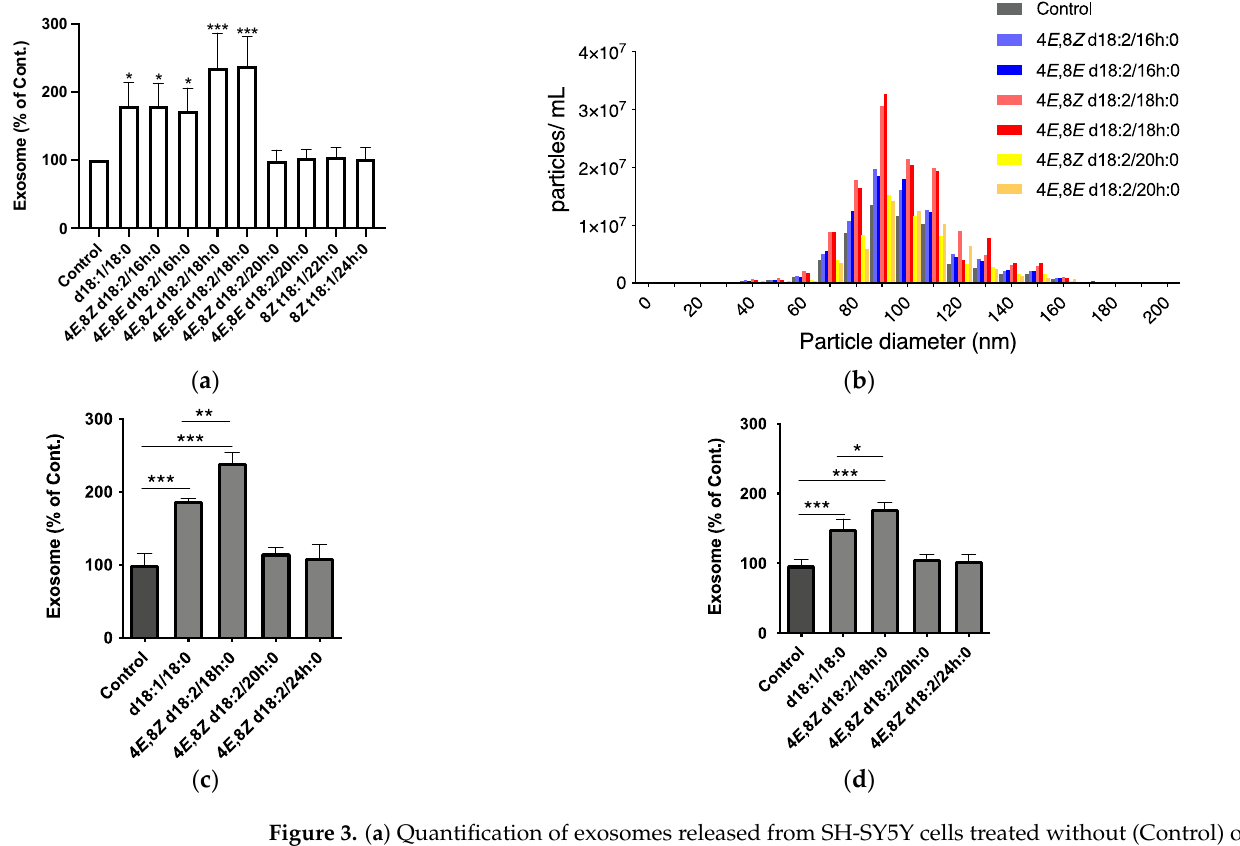
Figure 3. ( a ) Quantification of exosomes released from SH-SY5Y cells treated without (Control) or with typical plant Cers for 24 h. Exosomes were quantified using a PS-Capture Exosome ELISA system. Results are normalized against controls and represented as the mean ± SD ( n = 3; * p < 0.05, *** p < 0.0001 vs. Control). ( b ) Particle size distribution of exosomes derived from control and Cer-treated cells. ( c , d ) Quantification of exosomes released from primary mouse neurons ( c ) and human iPS neurons treated without (Control) or with the indicated Cers for 24 h ( d ). Exosomes were measured using a PS-Capture Exosome ELISA system. Results were normalized against controls and represented as the mean ± SD ( n = 3; * p < 0.05, ** p < 0.01, *** p < 0.001 by one-way ANOVA).